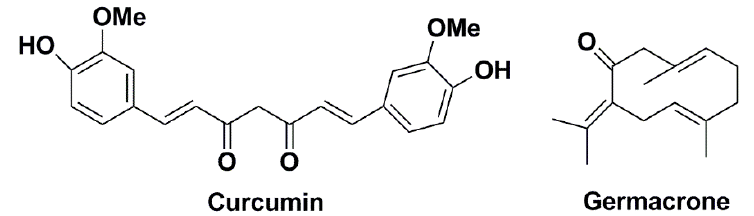
Figure 1. Chemical structures of curcumin and germacrone.